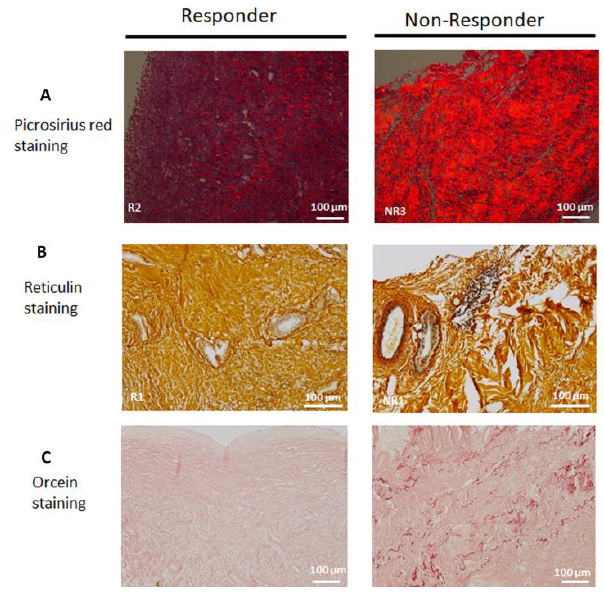
Figure 5. Representative pictures of picrosirius red ( A ), reticulin ( B ) and orcein ( C ) staining in responder and non-responder induced membranes. Scale bars = 100 µm.